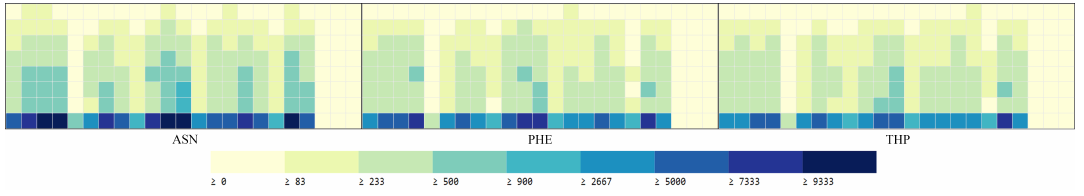
Figure 6. Feature maps of paiwise amino acid distances.